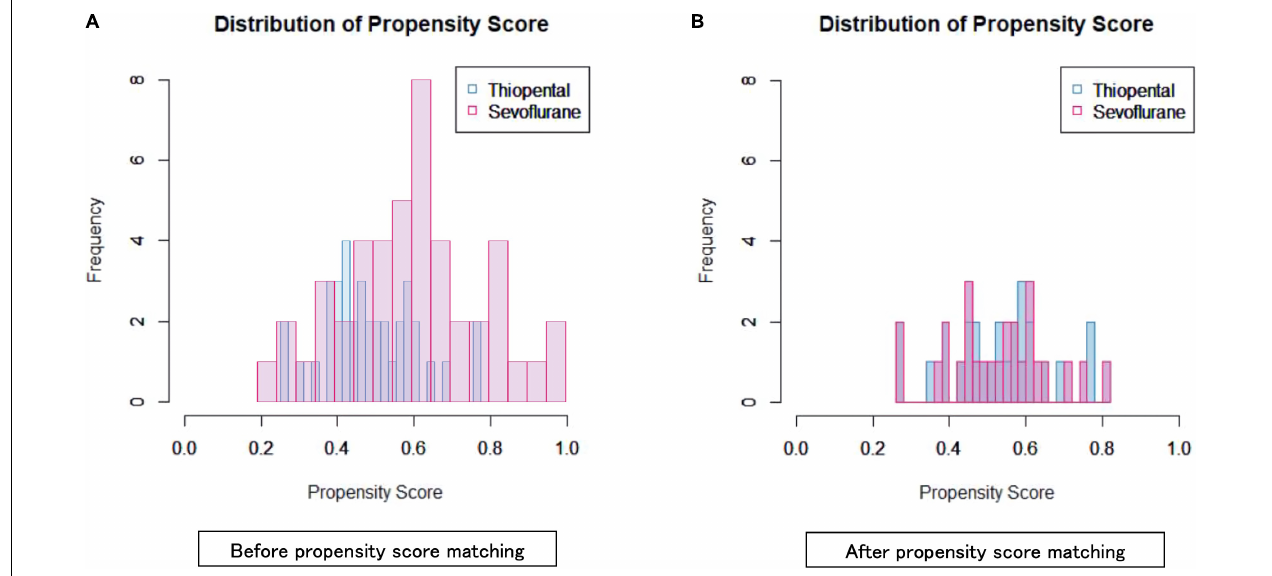
FIGURE 3 | Propensity score distribution in the sevoflurane and thiopental groups before (A) and after (B) propensity score matching.